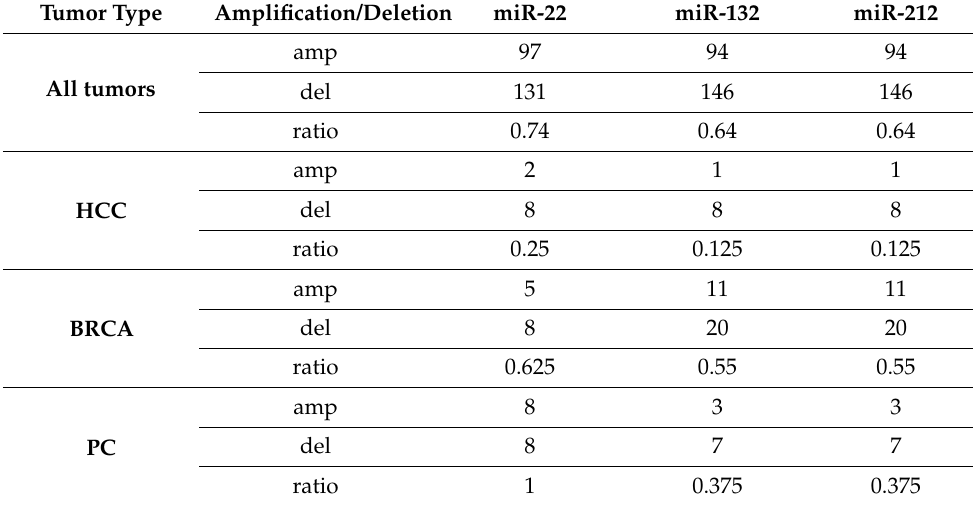
Table 3. The number of amplifications and deletions reported in the cBioportal database (cbiopor- tal.org) for the three microRNAs (miR-22, miR-132, and miR-212) in all tumors and, in breast cancer (BRCA), in hepatocellular carcinoma (HCC), and in prostate cancer (PC). Tumor Type Amplification/Deletion miR-22 miR-132 miR-212 amp All tumors